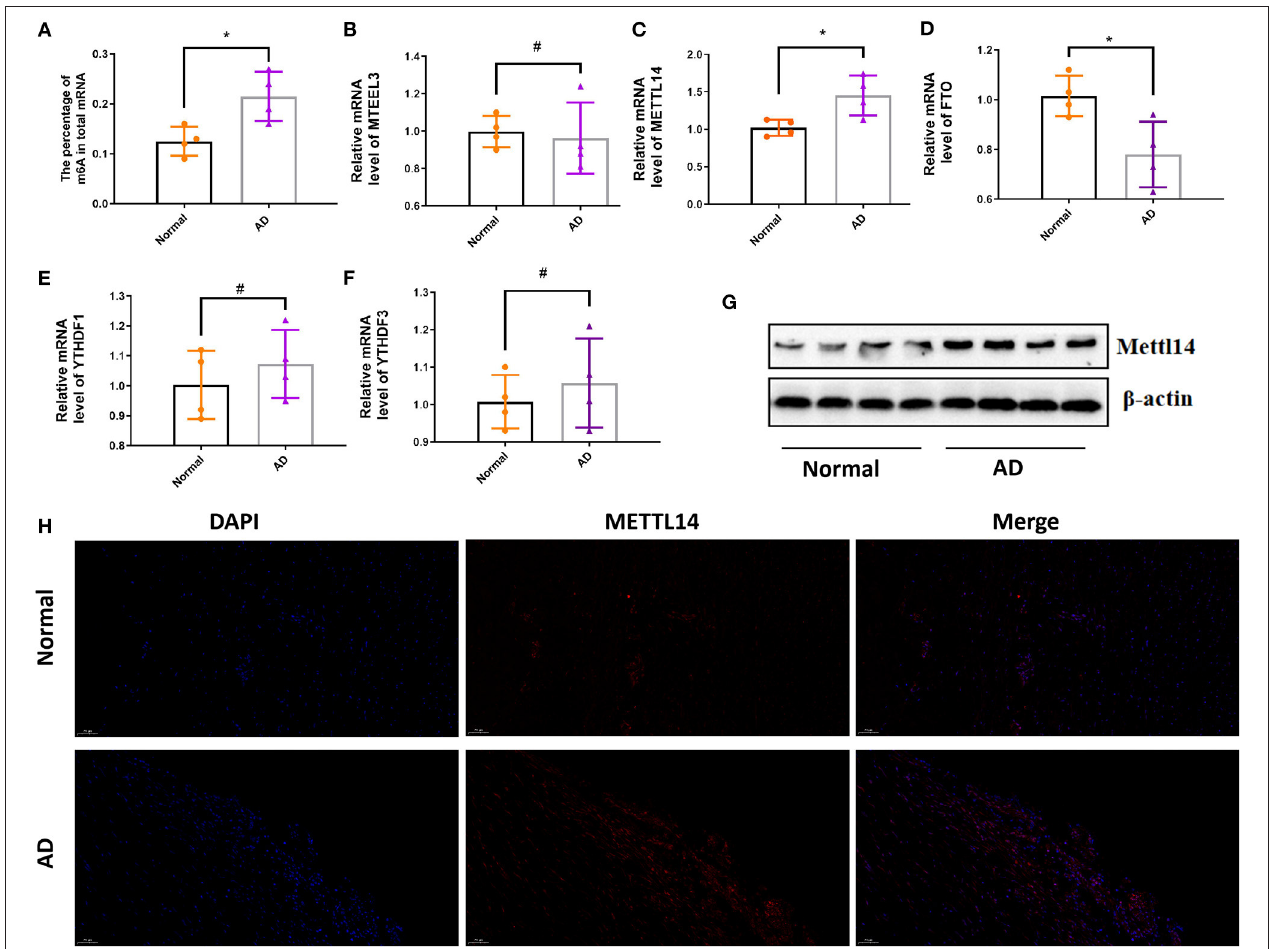
FIGURE 1 | The expression of m6A level and m6A methylation regulatory genes in AD. The mRNA m6A level and m6A methylation regulatory genes at the mRNA level in AD compared with the normal aortas. (A) The mRNA m6A level in AD and normal aortas; (B–F) The mRNA expression of METTL3, METTL14, FTO, YTHDF1 and YTHDF3 in AD and normal aortas. GAPDH was used as an internal control. (G) Western blot analysis of the METTL14 in AD and normal aortas. All of the results represent the mean ± standard deviation of three independent experiments ( n = 4). (H) Representative immunofluorescent staining of METTL14, and 4’,6-diamidino-2-phenylindole (DAPI) in AD and normal aortas (scale bars, 50 µ m). * P < 0.05, # P >